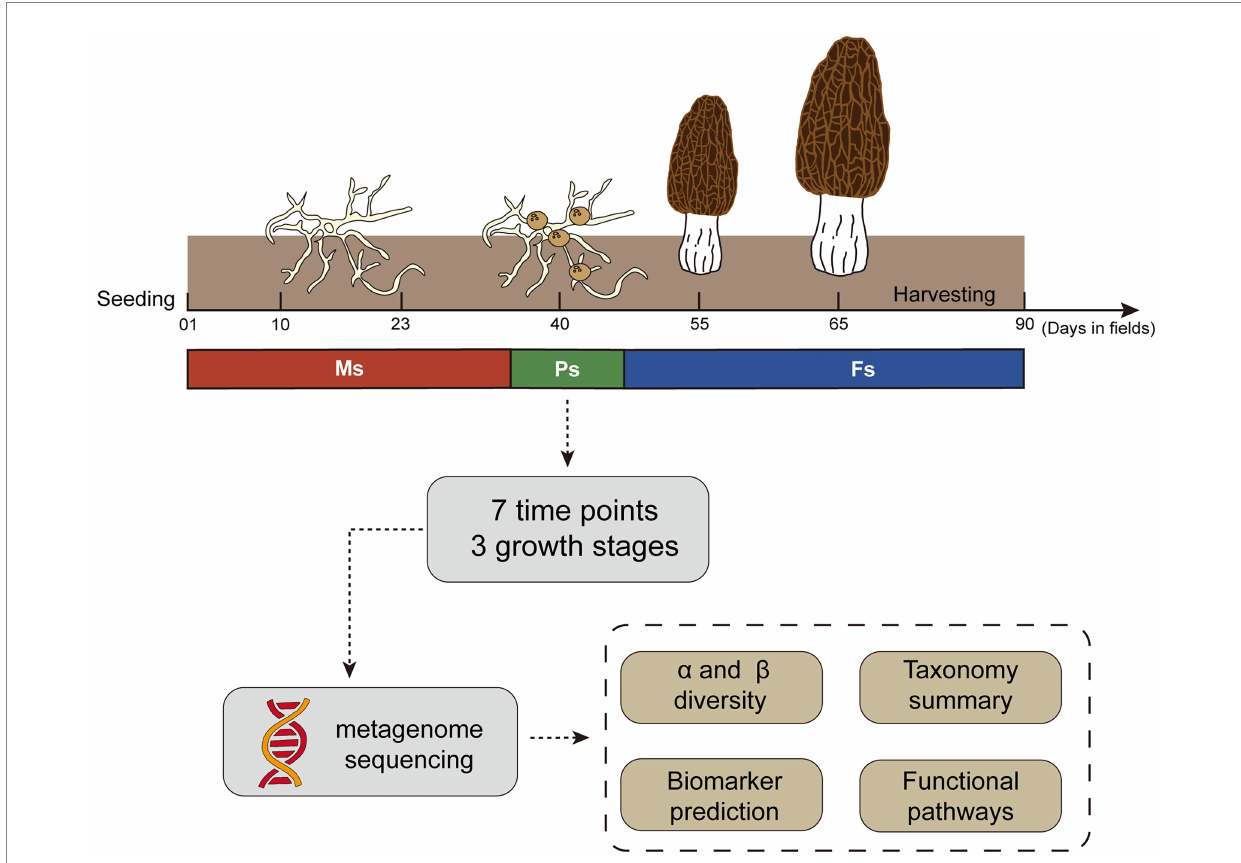
FIGURE 1 Outline of the study design and sampling strategy used throughout the Morchella sextelata cultivation life cycle. Ms, mycelium stage; Ps, primordium stage; Fs, fruiting body